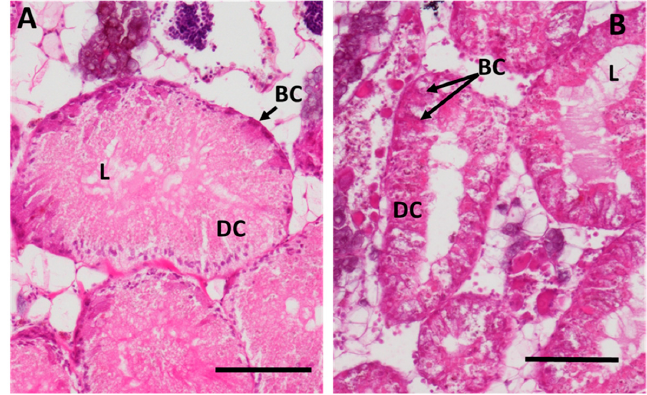
Figure 8. ( A ) Detailed view of the midgut gland tubules (hematoxylin-eosin staining) of a control periwinkle and ( B ) of a periwinkle of the CdH group after an exposure of 21 days. Note the drastic increase of the relative number of basophilic cells (arrows) and the enlarged lumen in ( B ), compared to control conditions ( A ). Scale bars: 200 µm; Abbreviations: L: lumen, DC: digestive cells, BC: basophilic cells.